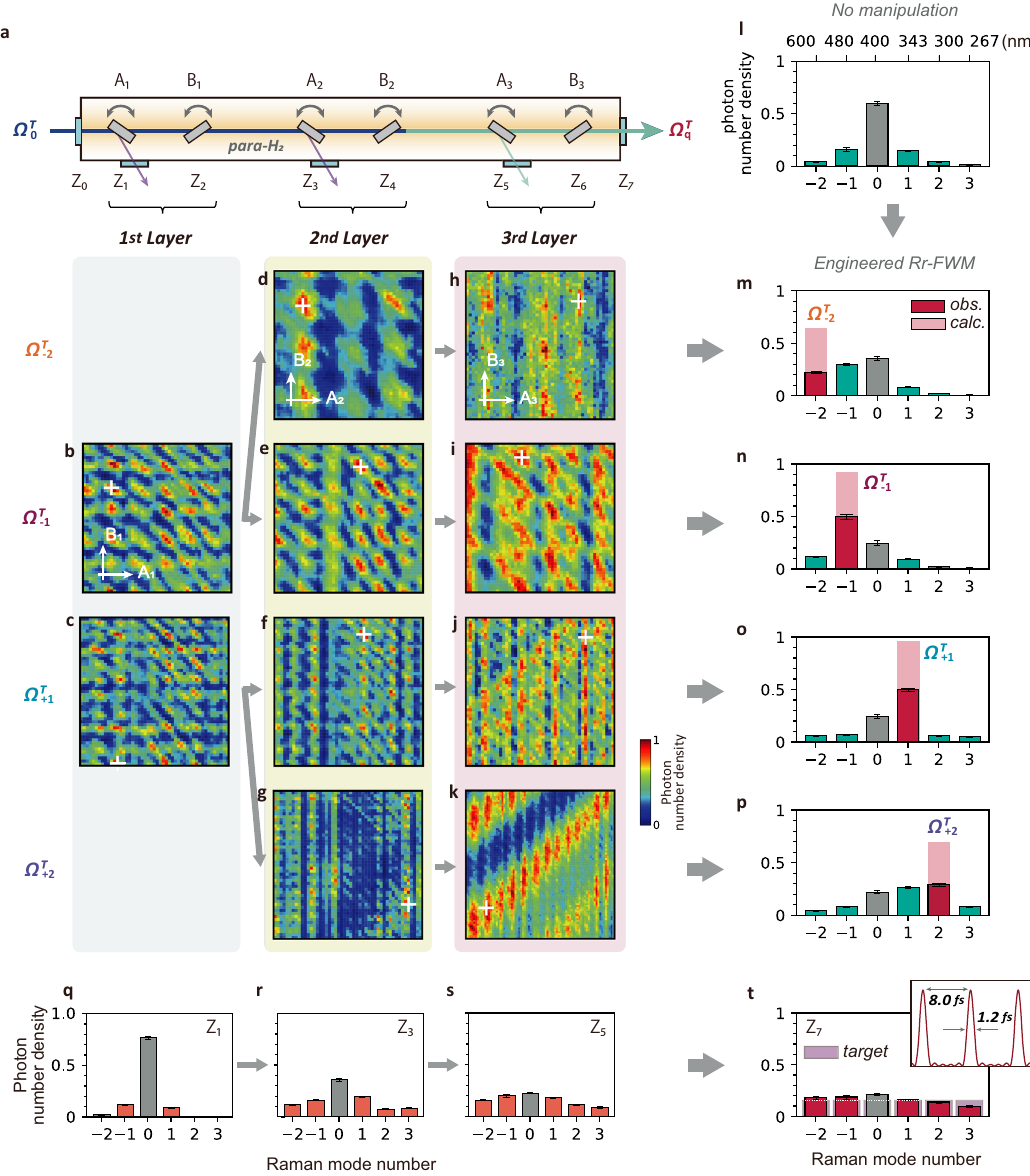
Fig. 3 Demonstrations of the engineered Raman-resonant four-wave-mixing (Rr-FWM) processes. a Schematic layout of the engineered Rr-FWM process, where the relative-phase manipulations comprised three layers, each consisting of a pair of dispersive plates; 1st: A 1 (Z 1 = 45 mm), B 1 (Z 2 = 95 mm); 2nd: A 2 (Z 3 = 145 mm), B 2 (Z 4 = 195 mm); 3rd: A 3 (Z 5 = 245 mm), B 3 (Z 6 = 295 mm). b – k Contour plots of photon number density for each of the Raman modes, Ω T (cid:1) to Ω T þ , observed after each of the three relative-phase manipulation layers (1st, b , c ; 2nd, d – g ; 3rd, h – k ). The crosses in the 2 2 contour plots indicate the optimal conditions explored in each of the three layers in each of the targets, which maximize a speci fi c Raman mode density of Ω T Ω T – p Photon number density distributions among the Raman modes, Ω T q = − 2 to 3; Ω T Ω T Ω T : 400.5408 nm, (cid:1) 2 to þ 2 . l q ( (cid:1) 2 : 600.8188 nm, (cid:1) 1 : 480.6514 nm, 0 Ω T Ω T Ω T fi nally achieved at the apparatus exit; for l , no manipulation was applied; for þ 1 : 343.3195 nm, þ 2 : 300.4038nm, þ 3 : 267.0250nm), which were to Ω T þ . The overlaid light red m – p , the plates were engineered towards each of the targets to maximize a speci fi c Raman mode density (red bars) from Ω T (cid:1) 2 2 bars show the photon number densities calculated by the numerical simulations. q – t Generation of an equal photon number density distribution over broad high-order Raman modes, Ω T (cid:1) to Ω T þ , was examined. The measurements were conducted at four interaction lengths of Z 1 ( q ), Z 3 ( r ), Z 5 ( s ), and Z 7 ( t ) at 2 2 the exit of the cell. This target was regarded as an opposite extreme to those executed in m – p . Each of the error bars in l – t implies a standard deviation in one hundred measurements executed for each of the Raman mode